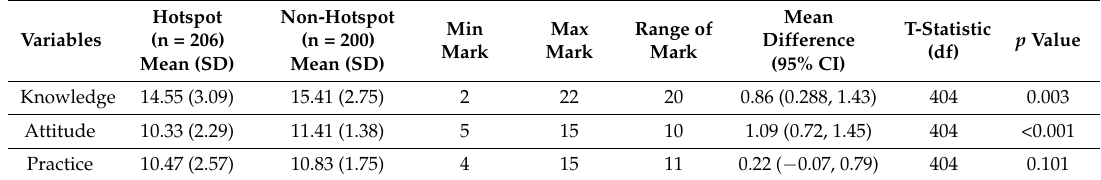
Table 5. Comparison of mean marks in Knowledge and Attitude between Hotspot and Non-hotspot Communities.